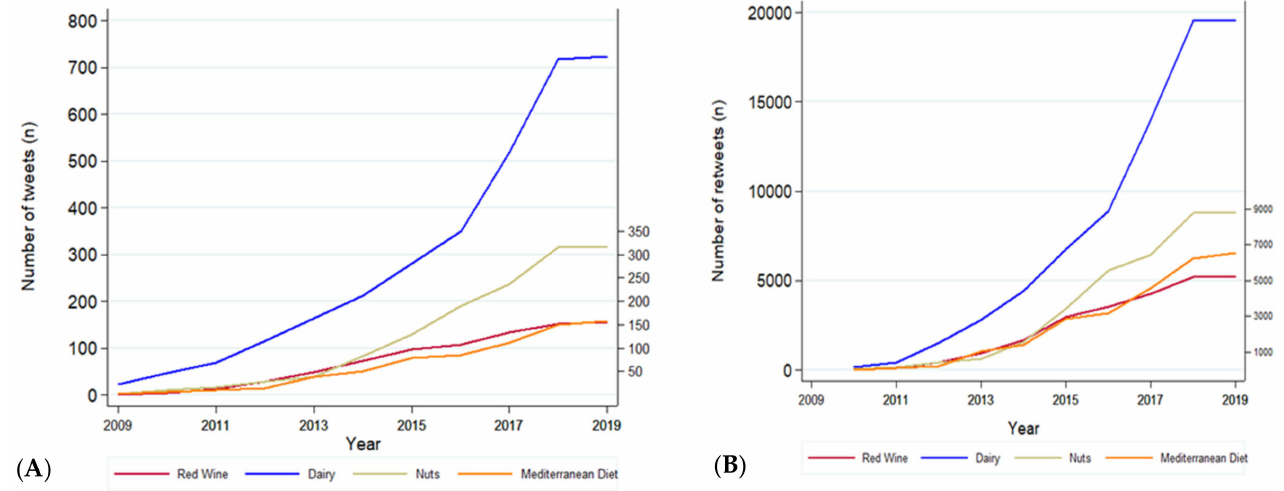
Figure 4. Time trend of all tweets ( A ) posted by the 25 major US media outlets selected in the study and the retweets generated by Twitter users ( B ) between 2009 and 2019. The data are shown for food groups that generated at least 15 tweets per year.